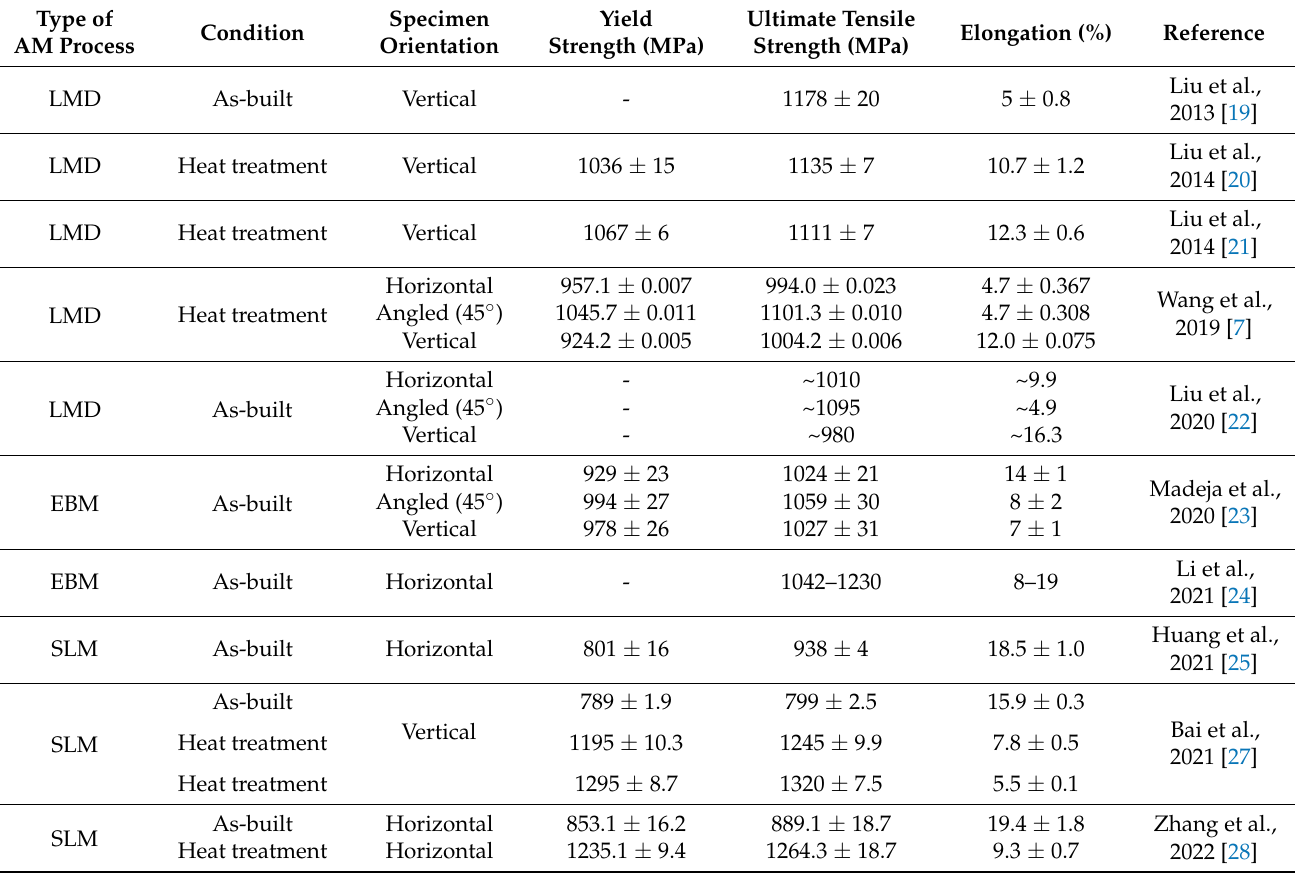
Table 1. A summary of mechanical properties of relevant Ti-5Al-5Mo-5V-1Cr-1Fe alloys reported in the literature.